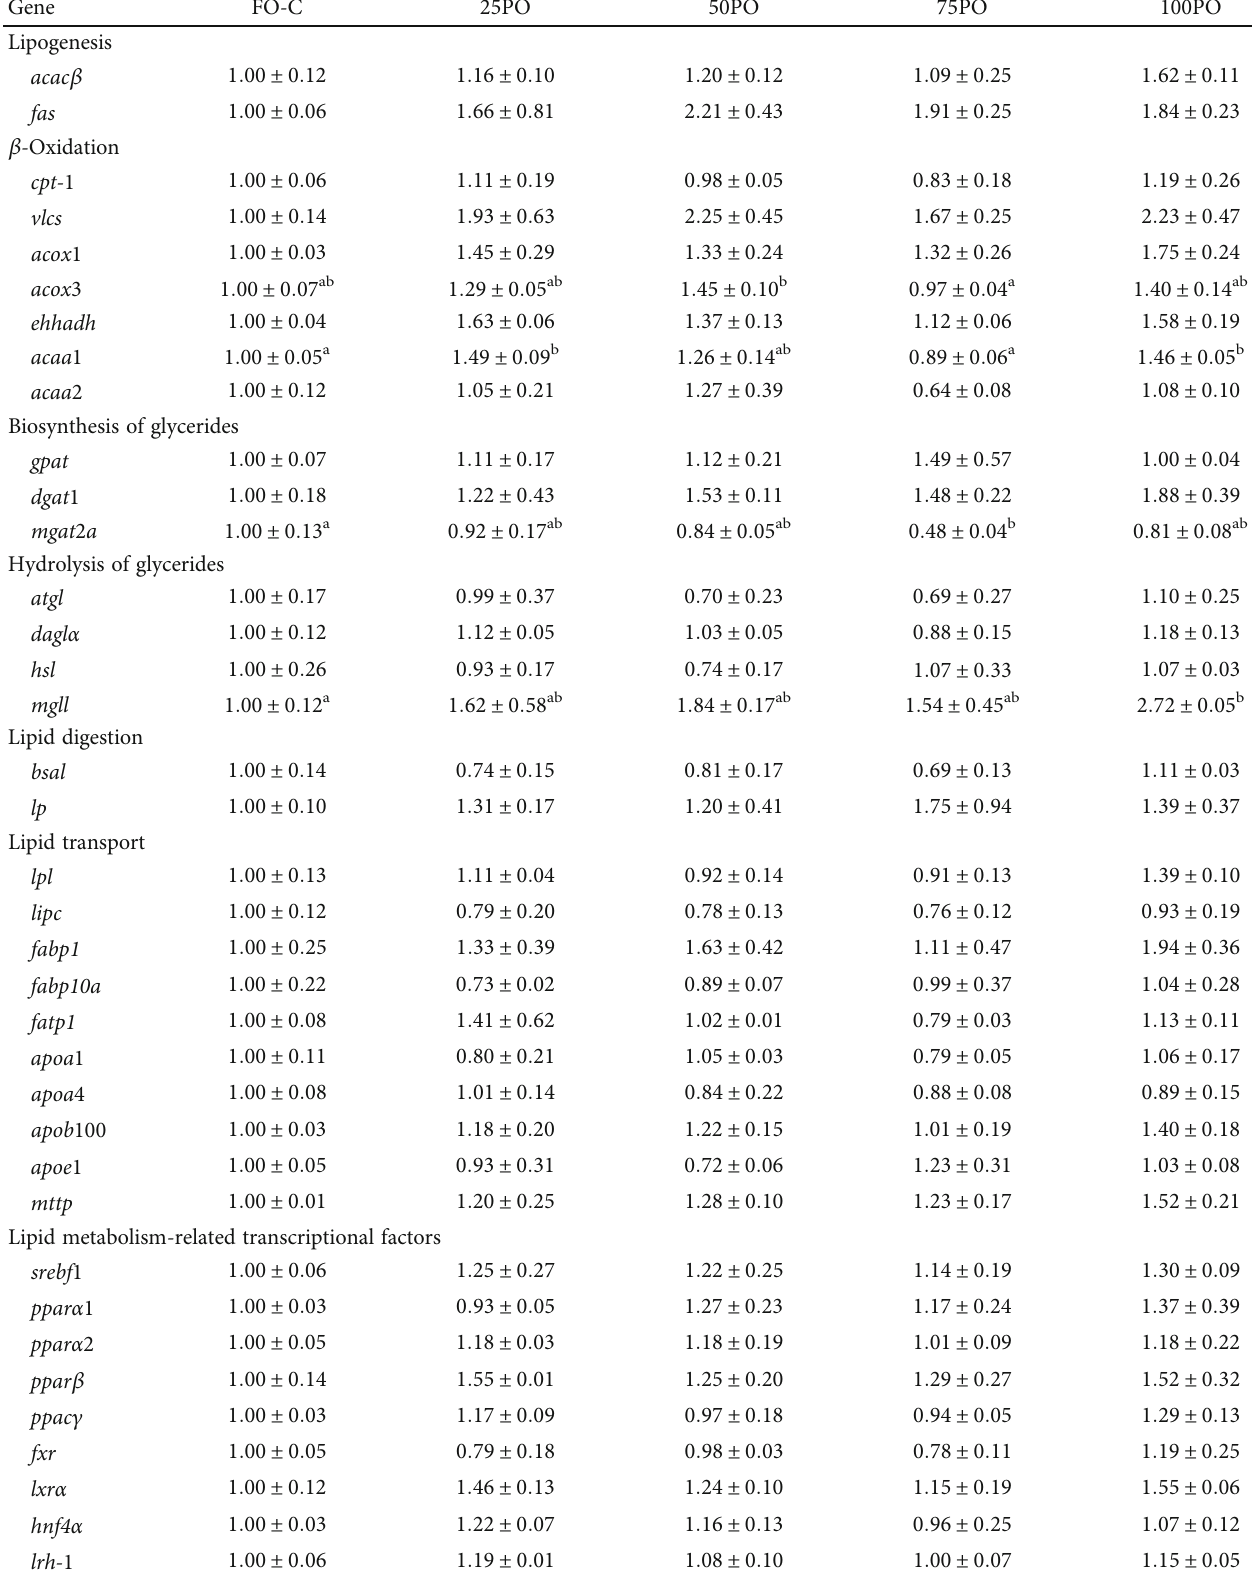
Table 7: Relative mRNA expression levels of genes related to lipid metabolism in the liver of experimental tiger pu ff er at the end of the growing-out period ( mean ± standard error